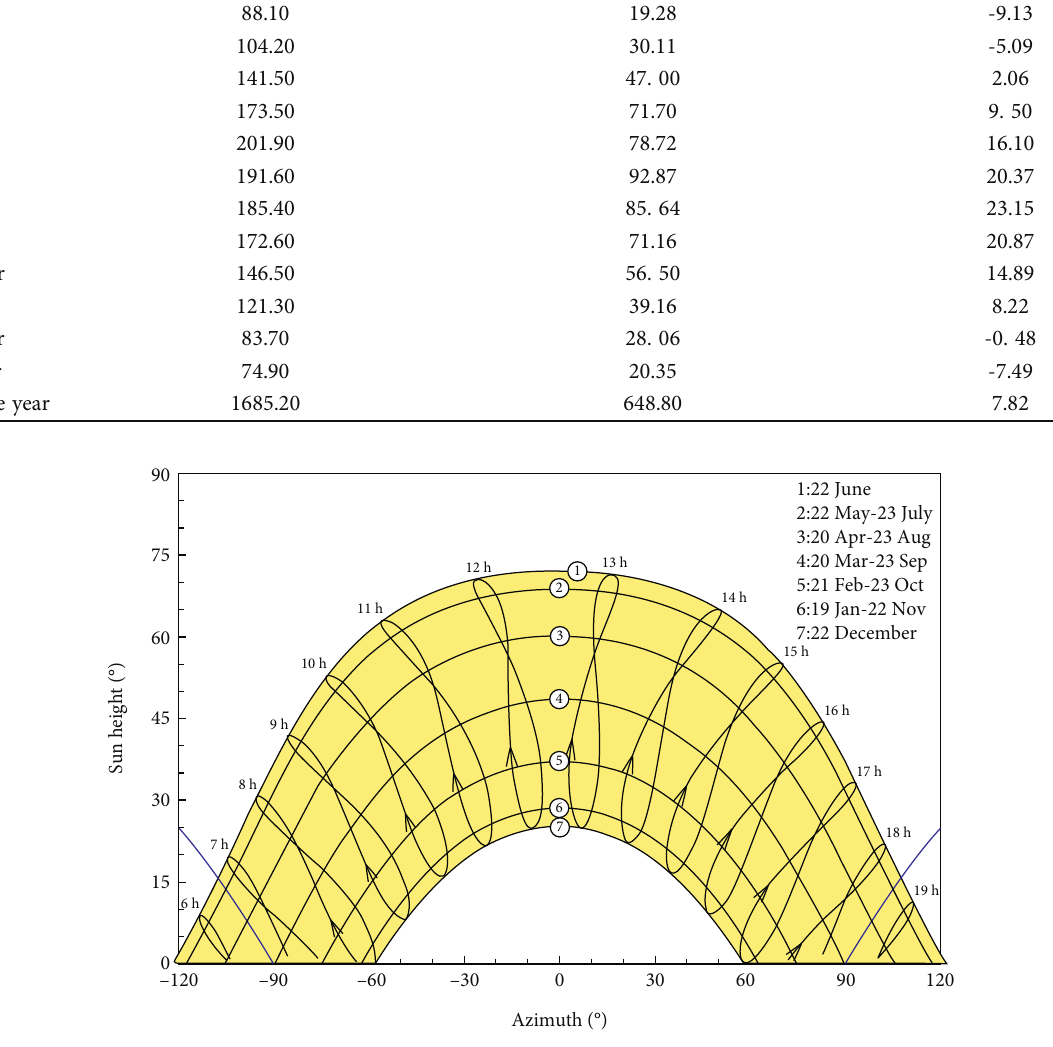
Figure 4: Trajectory map of solar altitude by